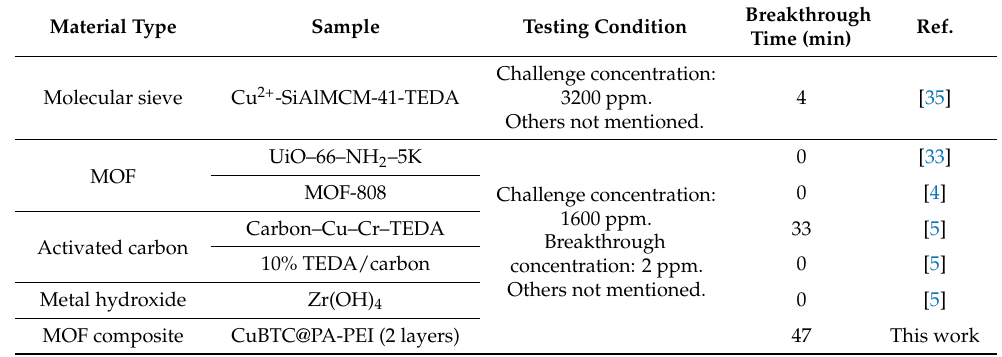
Table 3. Breakthrough time comparison of other materials reported in the literature.